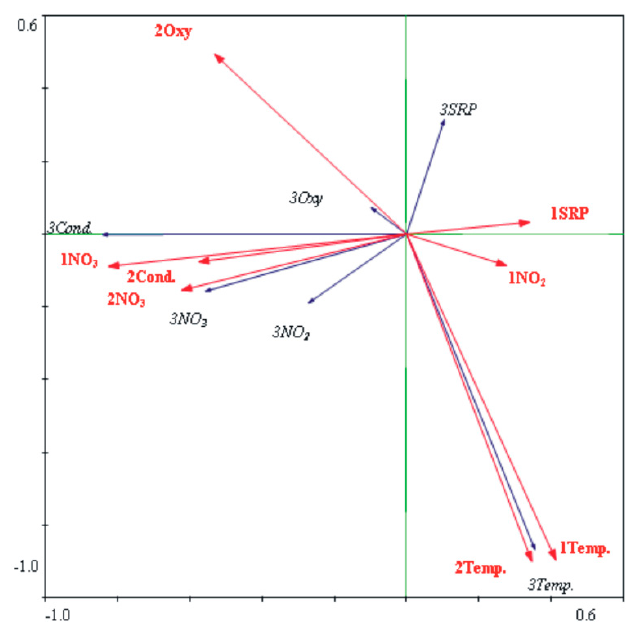
Figure 13. RDA biplot illustrating the influence of the River Struga Gołaniecka (Nos. 3) on mean values of water quality variables in the depth profile of the lake at Station I (Nos. 1) and Station II (Nos. 2).